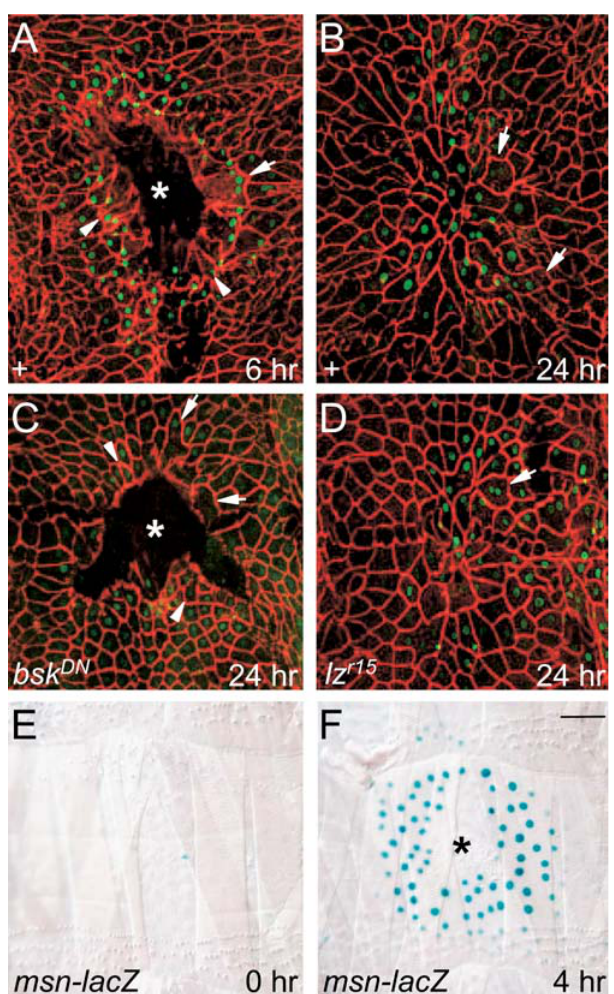
Figure 5. Cellular Responses and Genetic Requirements of Pinch Wound Healing (A–D) Larvae carrying the msn-lacZ reporter and the indicated transgenes or mutations were pinched with a forceps to abrade a region of dorsal epidermis but leave the overlying cuticle intact. Wounded larvae were cultured for the indicated times and immunostained for Fasciclin III (red) and b -galactosidase (green). (A) 6 h after pinch wounding. Note the large epidermal gap (asterisk) at the wound site. Some cells at the wound margin have elongated and oriented toward the wound (arrowheads). Others have fused to form syncytia (arrow). (B) 24 h after pinch wounding. The epidermis has spread to close the gap. Note disorganization of epidermis and syncytia (arrows) at site of healed wound. (C) An A58-Gal4 and UAS-bsk DN larva 24 h after pinch wounding. Epidermal spreading is inhibited and a large wound gap remains (asterisk). However, cells at the wound margin still orient toward the wound (arrowheads) and fuse to form syncytia (arrows). (D) A hemizygous lz r15 mutant larva 24 h after pinch wounding. lz r15 blocks crystal cell development and scab formation at puncture wounds (Figure 6), but no defects are observed in pinch wound healing. (E and F) Larvae carrying msn-lacZ reporter were mock-wounded (E) or pinch wounded (F), cultured for 4 h, and stained with X-gal (blue). Wounding induces reporter expression in a gradient extending out four cell diameters. The gap (asterisk) lacks a scab. Bar, 100 l M. DOI: